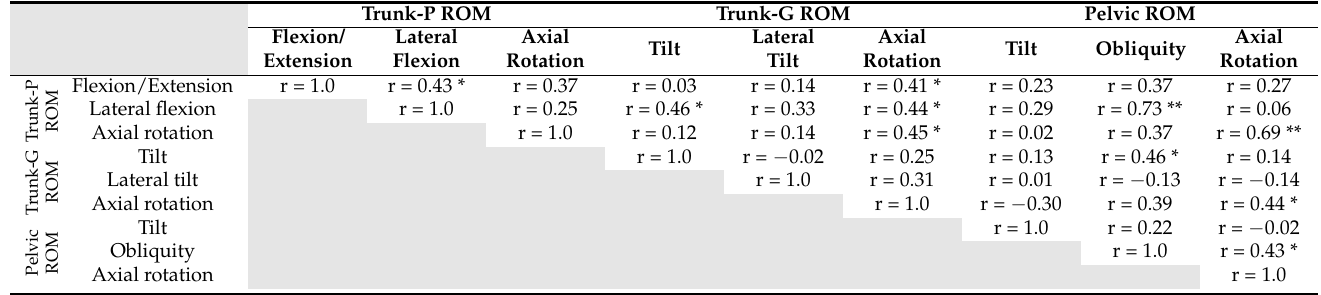
Table 3. Zero-order correlation coefficients for ROM between the trunk-P, trunk-G, and pelvis in all cardinal